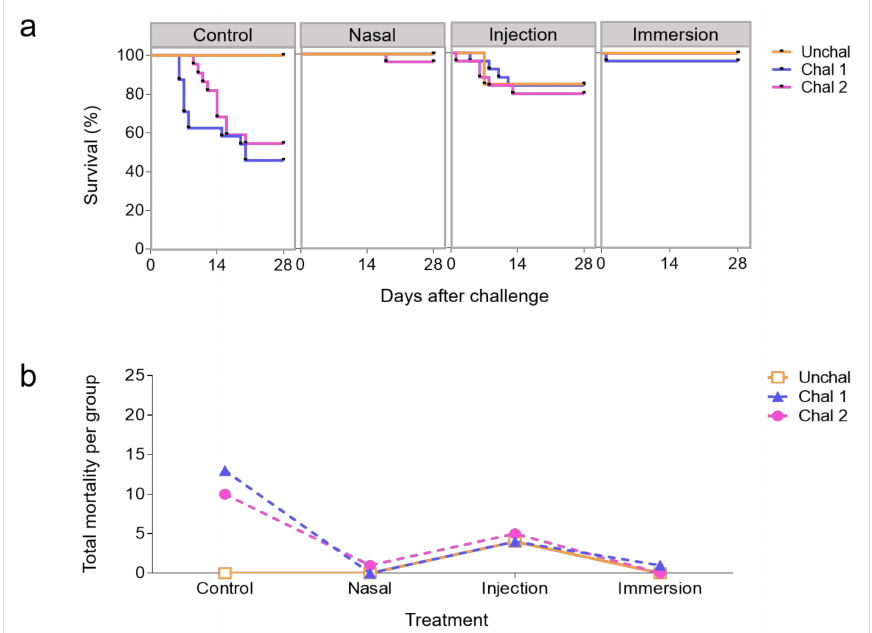
Figure 3. Protection conferred by live attenuated IHNV vaccine in trout. Survival curves ( a ) and total mortality ( b ) of trout vaccinated with live attenuated IHNV intranasally (IN), by intramuscular (i.m.) injection or by immersion (imm). Trout ( N = 25 per tank in duplicate tanks) were challenged to virulent IHNV i.p. 7 dpv (5 PFU). Unchal, unchallenged; Chal1 and Chal2 refer to duplicate tanks that were challenged for each experimental group.